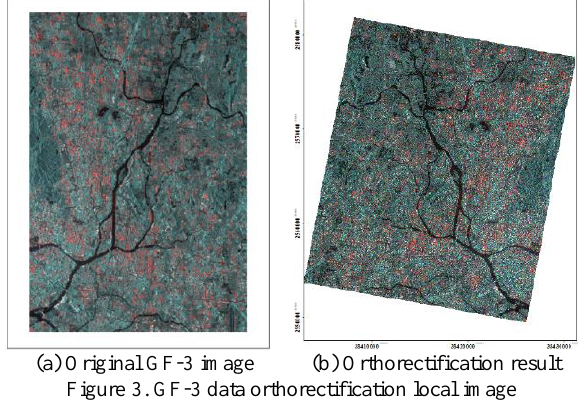
Figure 3. GF-3 data orthorectification local image